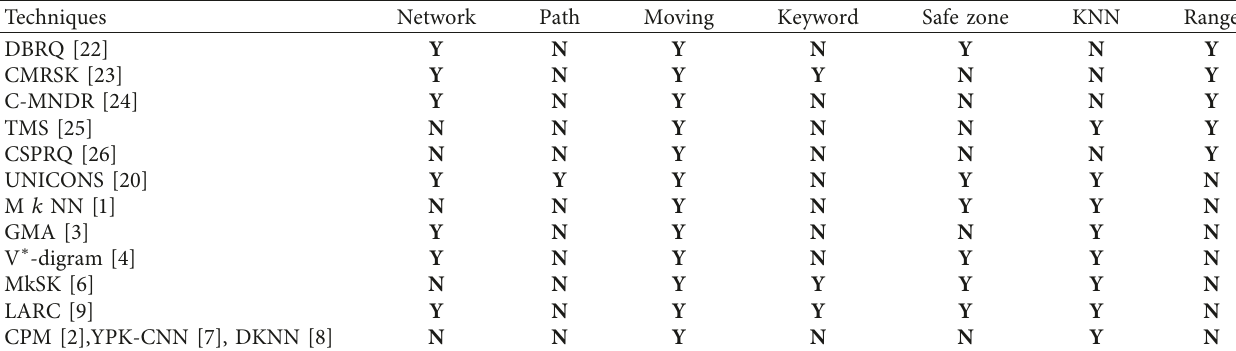
Table 1: Summary of the related works.